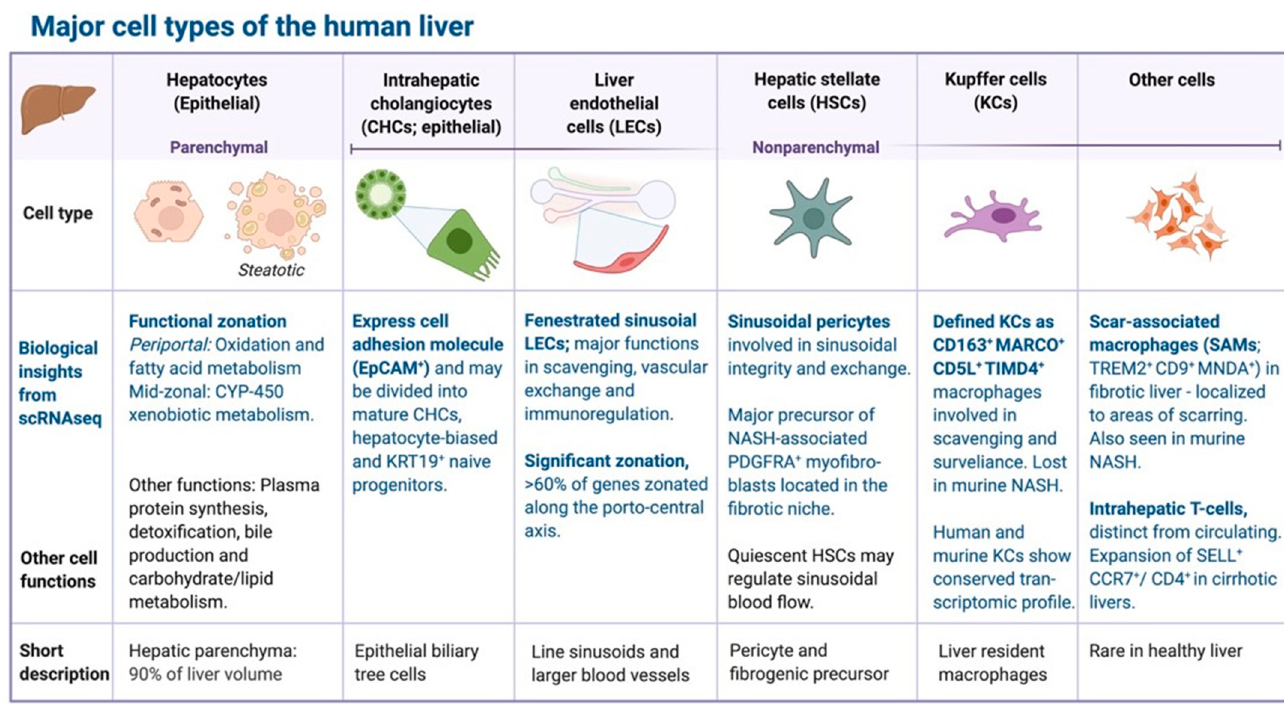
Figure 2. Major cell types of the human liver. Single-cell and cell type-resolved omics studies have all added to our understanding of liver biology in health and disease.